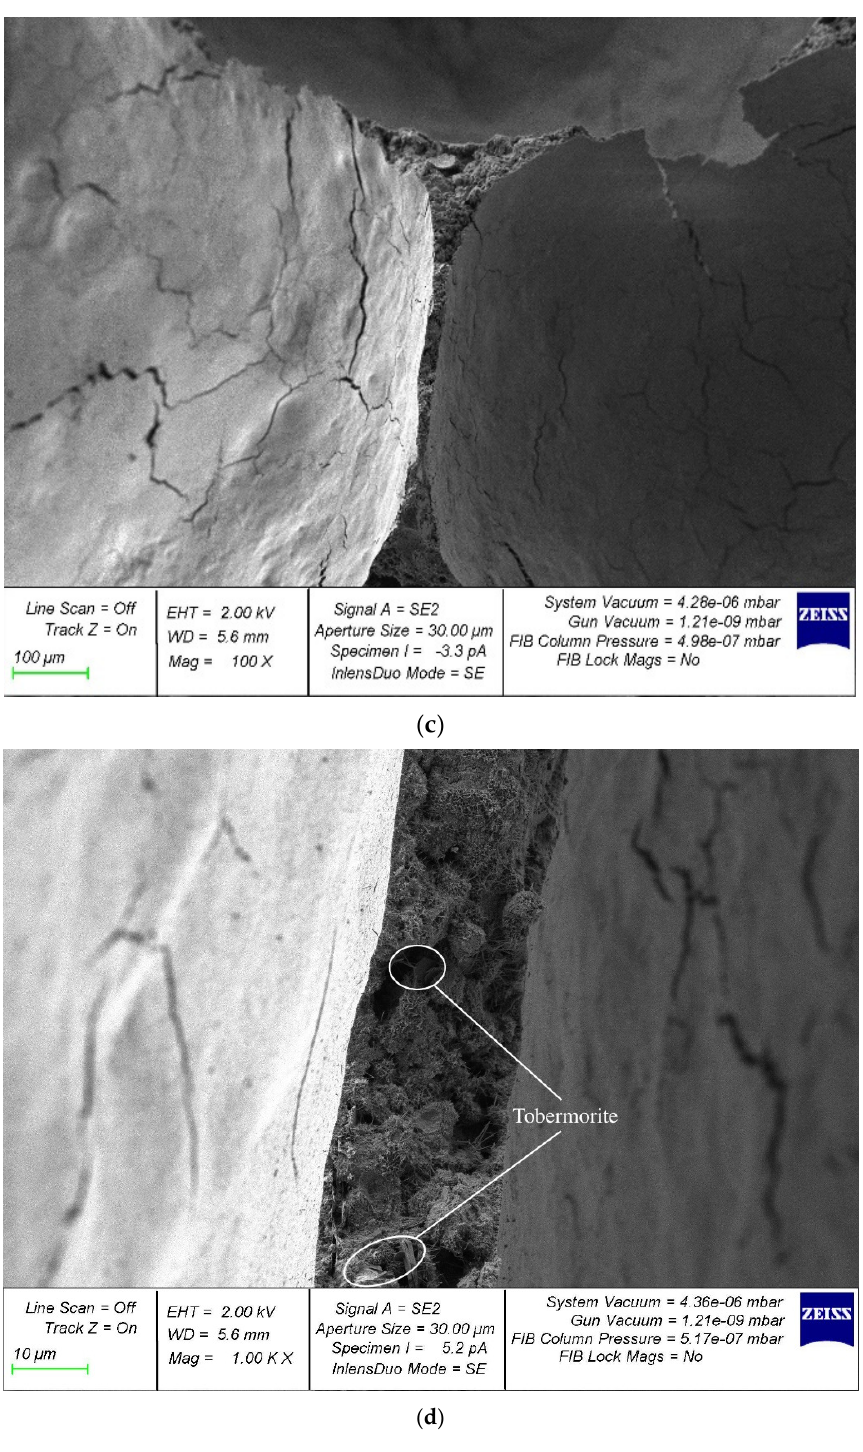
Figure 9. SEM of non-autoclaved aerated concrete samples: ( a ) control composition at 300× magni- fication; ( b ) control formulation at 2000× magnification; ( c ) with the addition of microsilica in the amount of 16% with a 100-fold increase; ( d ) with the addition of microsilica in the amount of 16% with a 1000-fold increase.